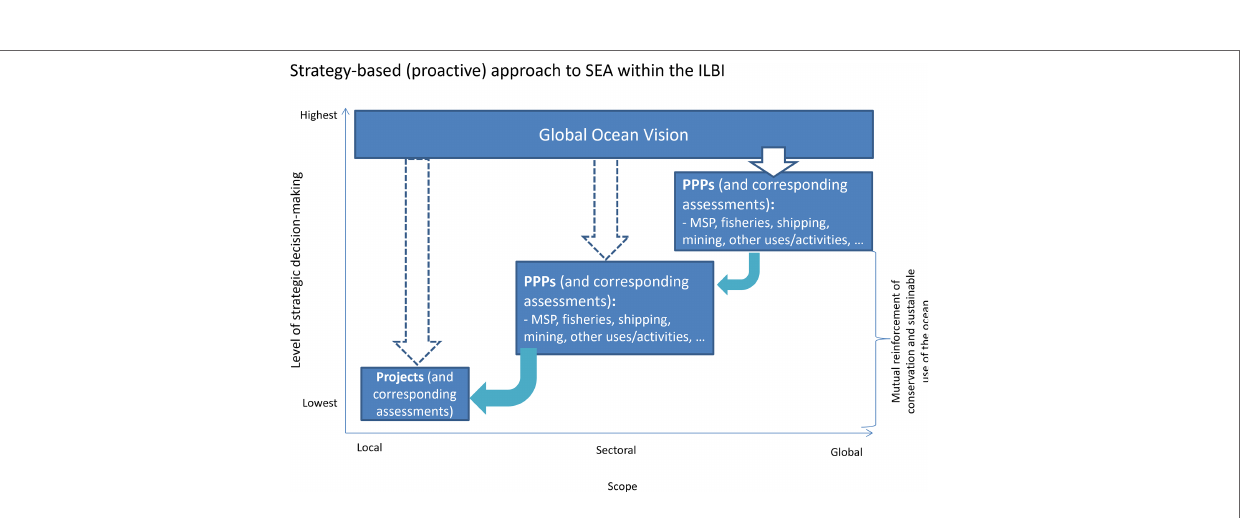
FIGURE 2 | Proactive strategy-based SEA positioning within the ILBI.